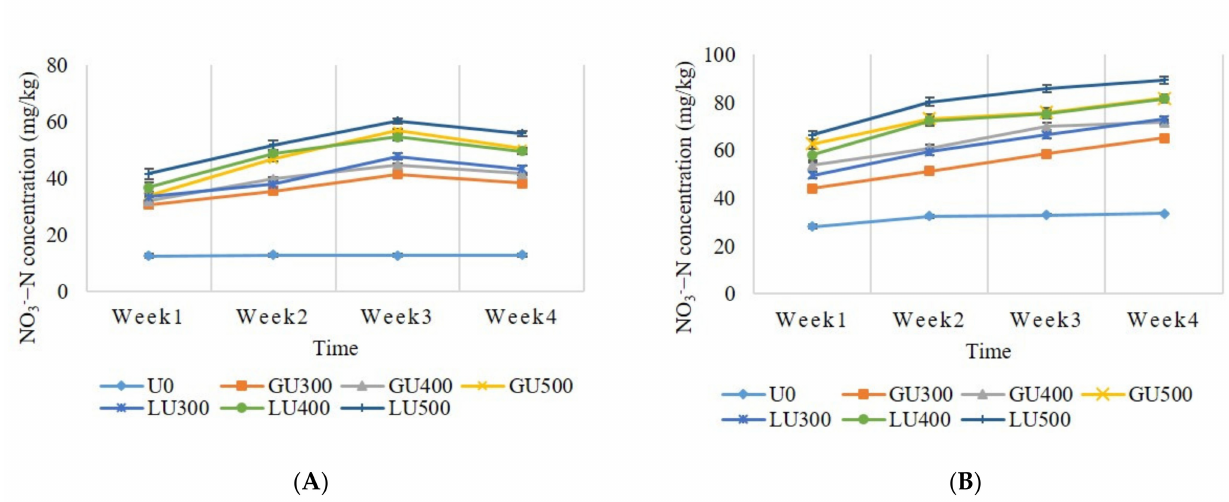
Figure 2. NO 3- -N concentration in Bungor ( A ) and Selangor ( B ) soils treated with different rate of LU and GU fertilizers during the four weeks of incubation. Vertical bars on the graphs show the standard